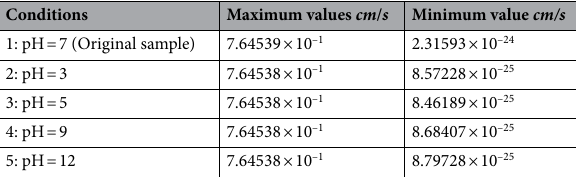
Table 3. Values of Darcys velocity under different conditions.